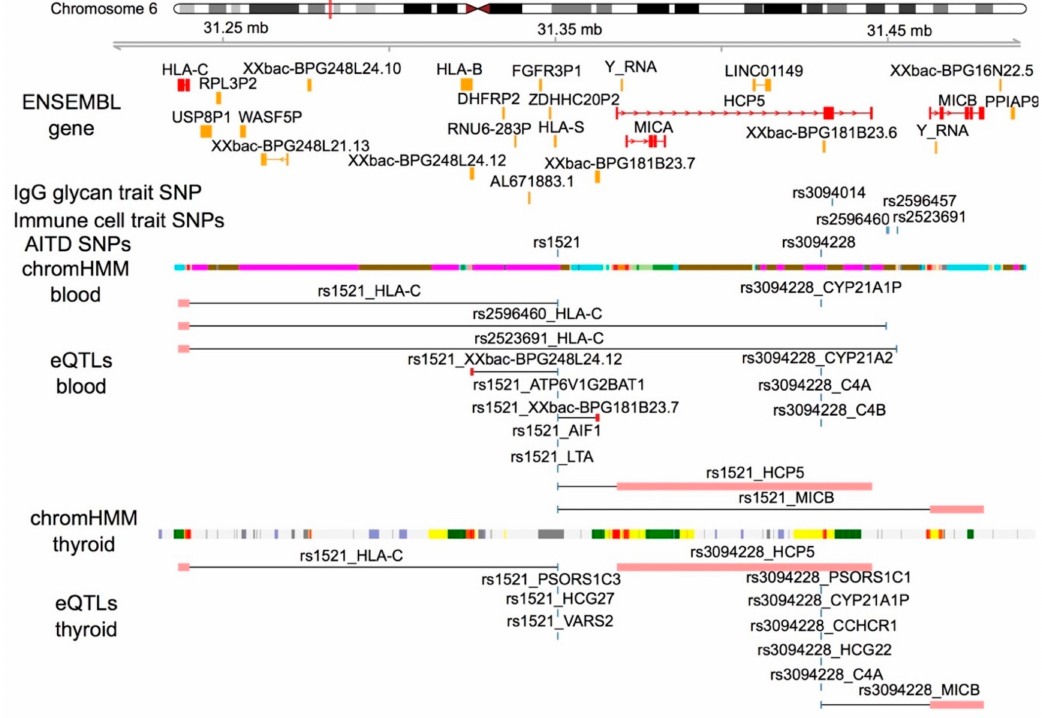
Figure 3. Association of immune cell traits with AITD status. Annotation tracks around MIC-A, MIC-B and HLA-C genes visualize significant GWAS hits for immune cell traits, the ligands of certain immunoreceptors (such as NK), and thyroid phenotypes previously identified in the TwinsUK cohort as well as chromatin states identified using chromHMM from whole blood from ENCODE [65] and thyroid cells from CEMT [66] and eQTLs from GTEx project [32,33]. The plot was produced